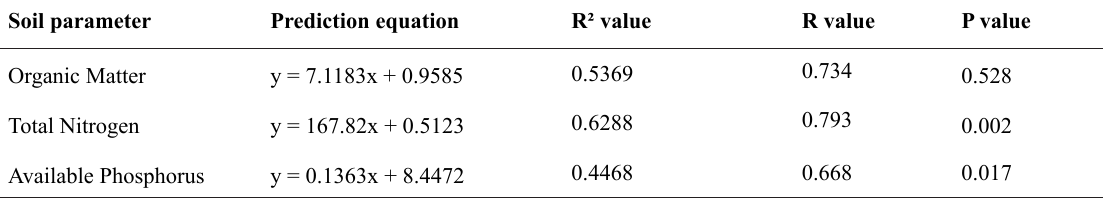
Table 7 Coefficients of regression between soil properties and okra yield performance Soil parameter Prediction equation R² value R value P value Organic Matter y = 7.1183x + 0.9585